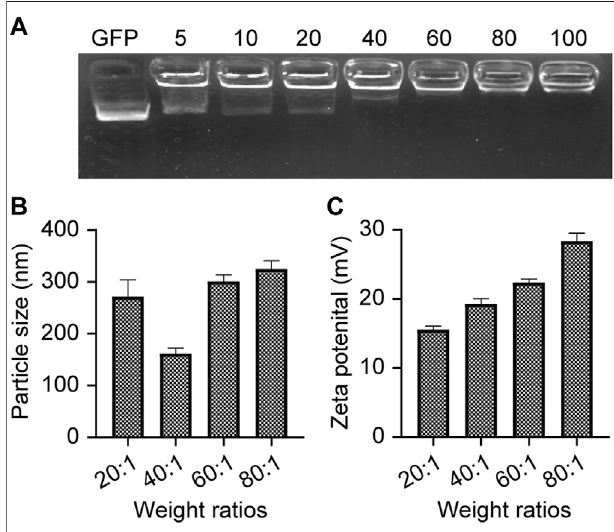
FIGURE 2 | Characterization of NPs. (A) Agarose gel (2%) electrophoresis of NPs composed of PBAE537 and GFP at different mass ratios. (B) Measurement of particle sizes of NPs with different mass ratios (PBAE537:GFP) and (C) zeta potentials by dynamic light scattering. The data represent the mean ± SEM ( n = 3 per